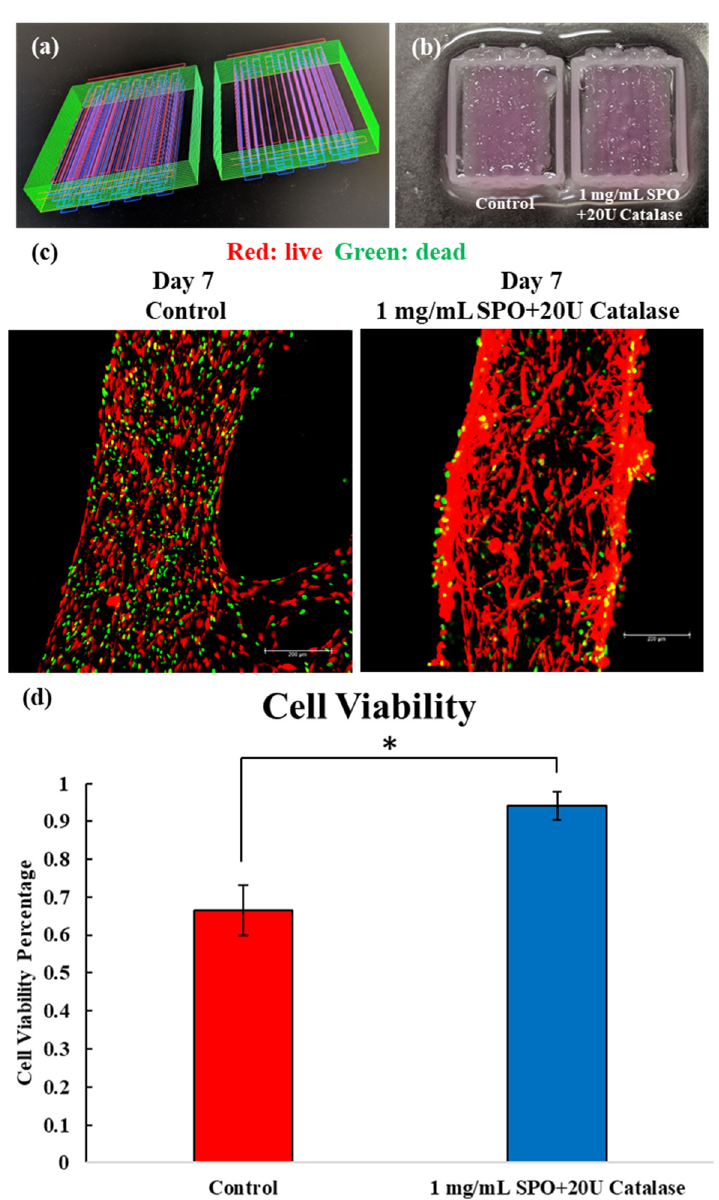
Figure 4. ( a ) Design of bioprinted muscle construct. ( b ) Bioprinted muscle construct using fibrinogen-based hydrogel and fibrinogen-based hydrogel with 1 mg/mL SPO + 20 U catalase. ( c ) Live–dead staining of bioprinted muscle construct after 7 days of culture under hypoxic conditions. Red indicates live cells and green indicates dead cells. ( d ) Cell viability of each composition was calculated based on the color area in the live–dead